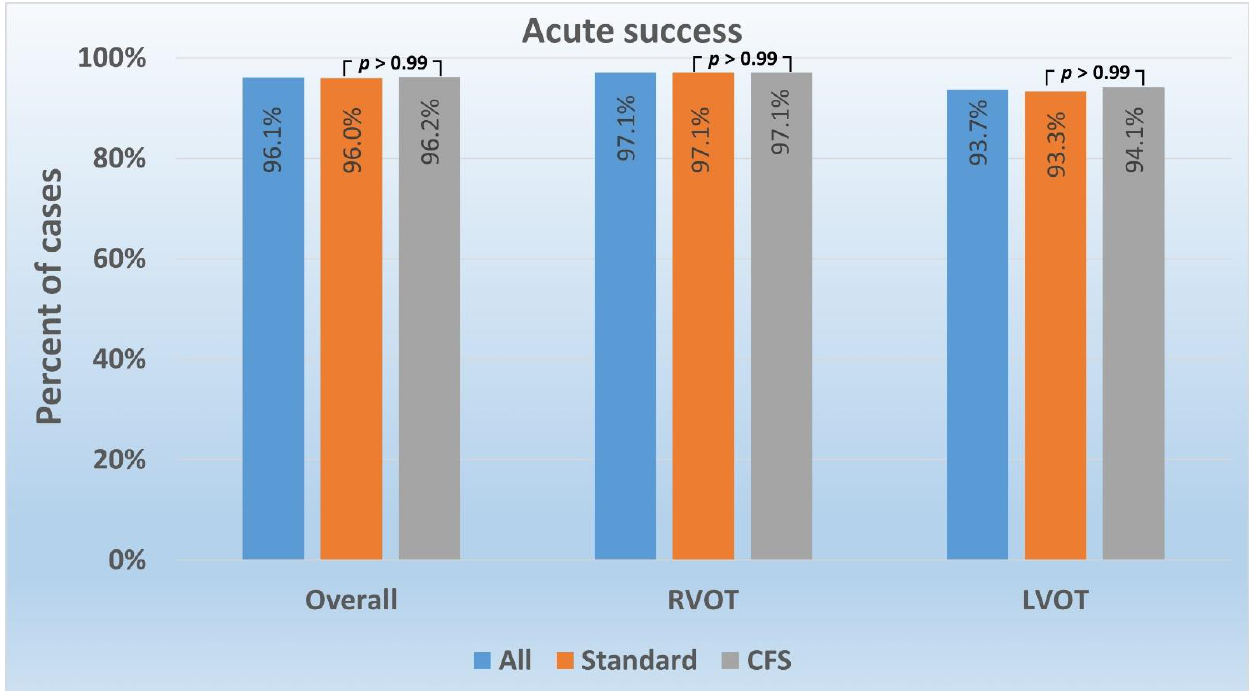
Figure 3. Premature ventricular contraction ablation acute success according to catheter type and arrhythmia localization. Abbreviations: CFS—contact force-sensing; LVOT—left ventricular outflow tract; RVOT—right ventricular outflow tract.